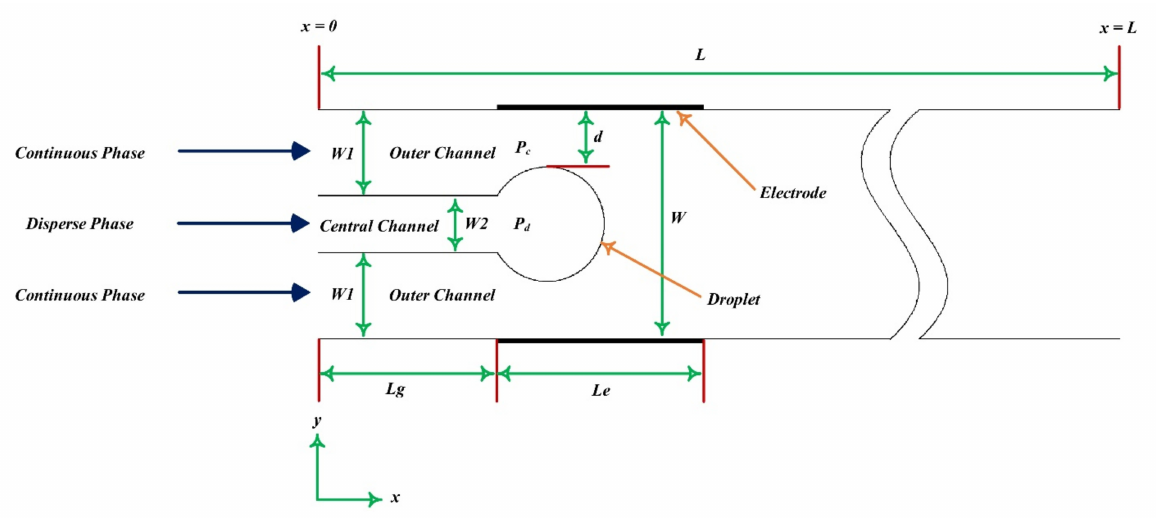
Figure 20. Upstream of a microchannel, diagrams showing the co-flowing of two immiscible fluids